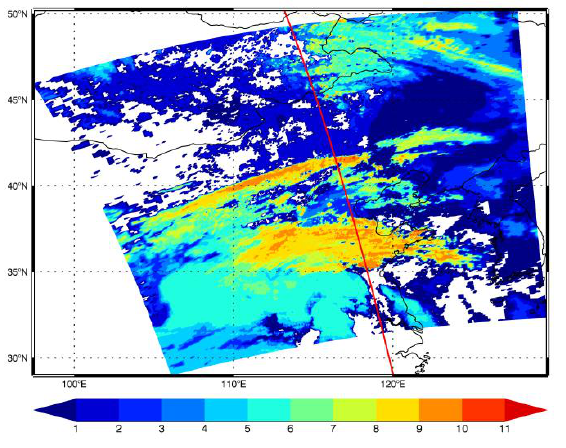
Figure 1. Image of cloud top height from MODIS at 05:25, Jan 1,